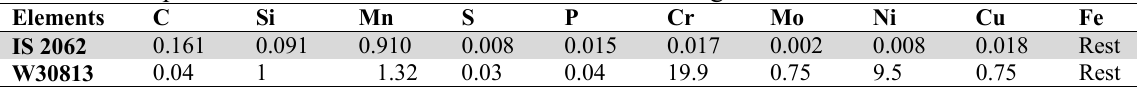
Chemical composition of based Metal and Filler wire in % weights